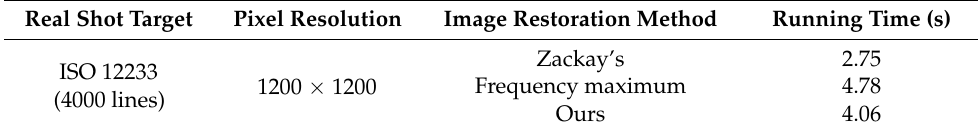
Table 3. Each algorithm’s running time when processing practical